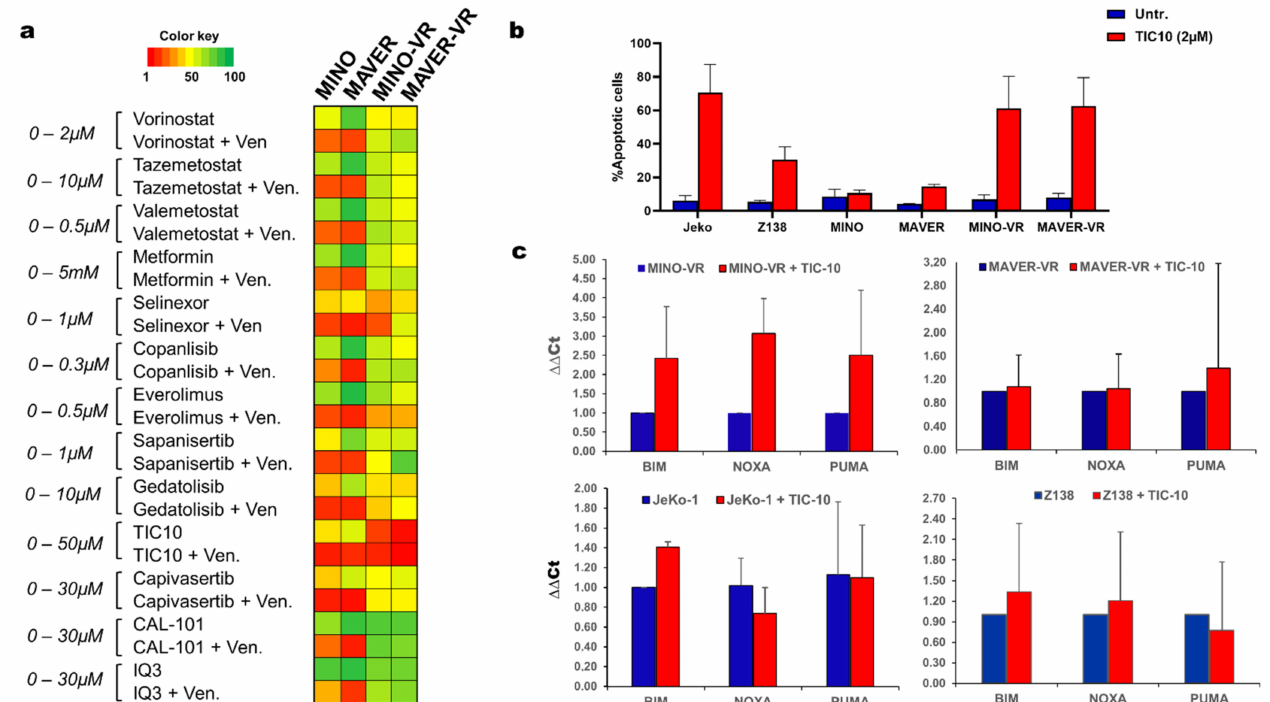
Figure 4. ( a ) Heatmap with the area under the curve (AUC) values for the drug-screen results using 13 different compounds with and without venetoclax for all cell lines. ( b ) Bar chart depicting the apoptotic response following treatment with 2 µ M TIC-10 for 72 h. Data are shown as mean + SD ( n = 3). ( c ) Bar charts with the relative expression of the pro-apoptotic transcripts BIM, PUMA and NOXA, before and after treatment with 2 µ M TIC-10 for 72 h, measured with qPCR and analyzed with the ∆∆ Ct method. Data are shown as mean + SD ( n =